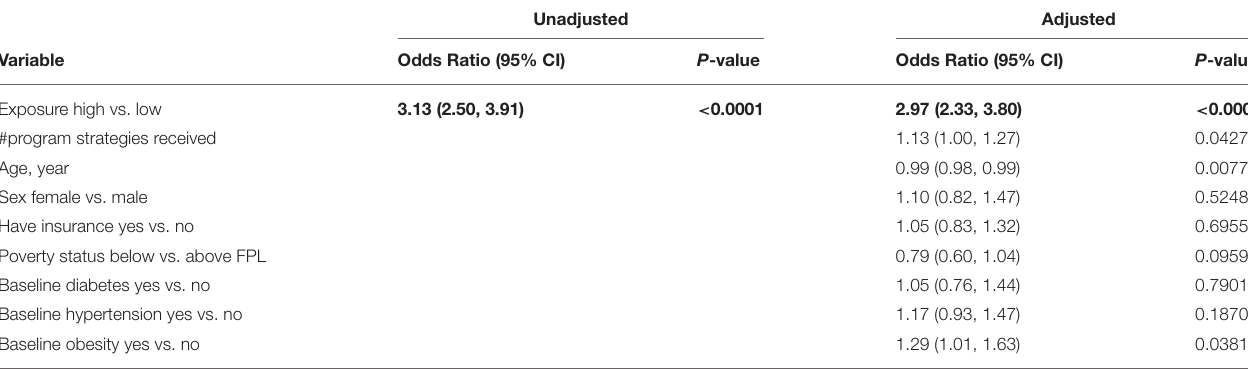
TABLE 4 | TSSC program effect on weight loss > 5% among the participants who had weight loss based on logistic regression analysis ( n = 3,272).